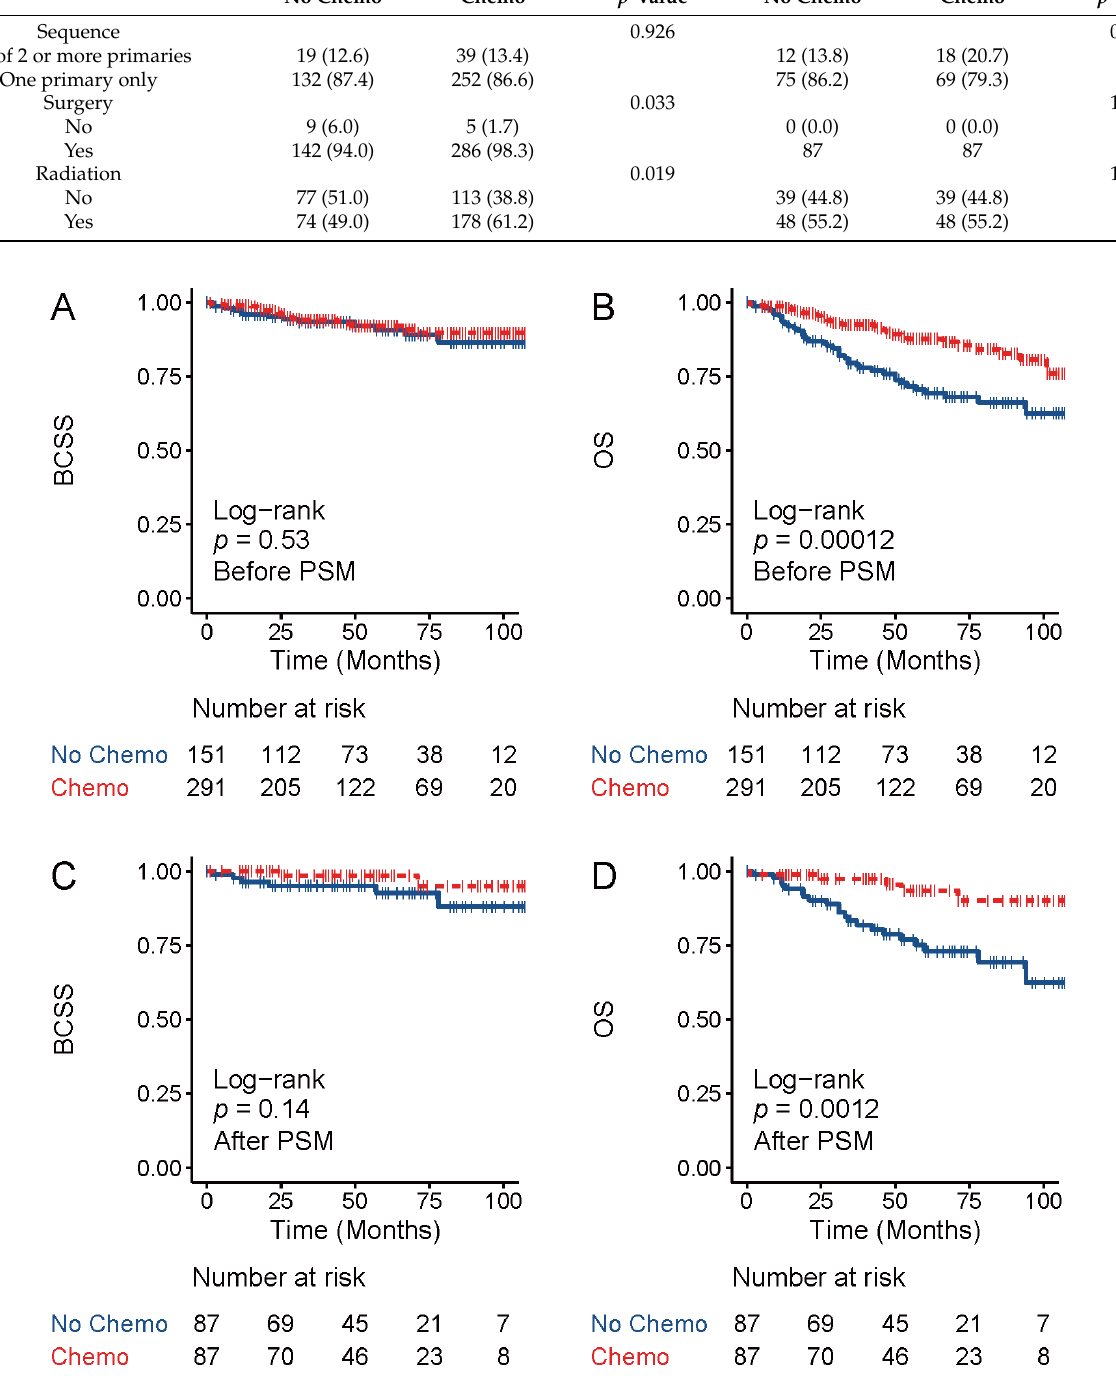
Figure 4. Survival plots of chemotherapy group and no-chemotherapy group of TNAC patients from SEER. Breast-cancer-specific survival (BCSS) and overall survival (OS) of TNAC patients be- fore matching ( A , B ) and after matching ( C , D ) were analyzed with Kaplan–Meier curves. Numbers at risk are displayed